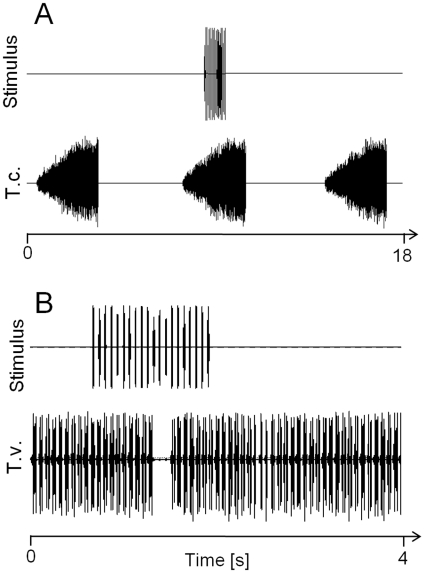
Examples of ultrasound stimulation of T. cantans and T. viridissima males.(A) T. cantans males were stimulated with repetitive 30 kHz pulses during verse production. The same stimulus frequently elicited brief song pausing in T. viridissima (B). Stimulus level was 89 dBpe SPL.